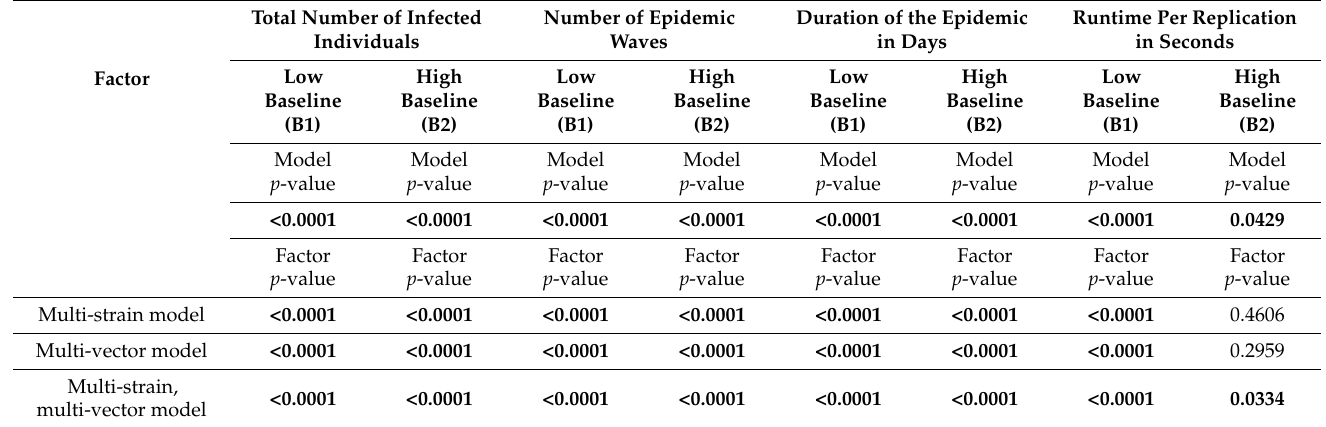
Table 12. ANOVA results for Model D (multi-strain, multi-vector dengue spread model) per baseline level. Bold font denotes statistical significance at α -level of